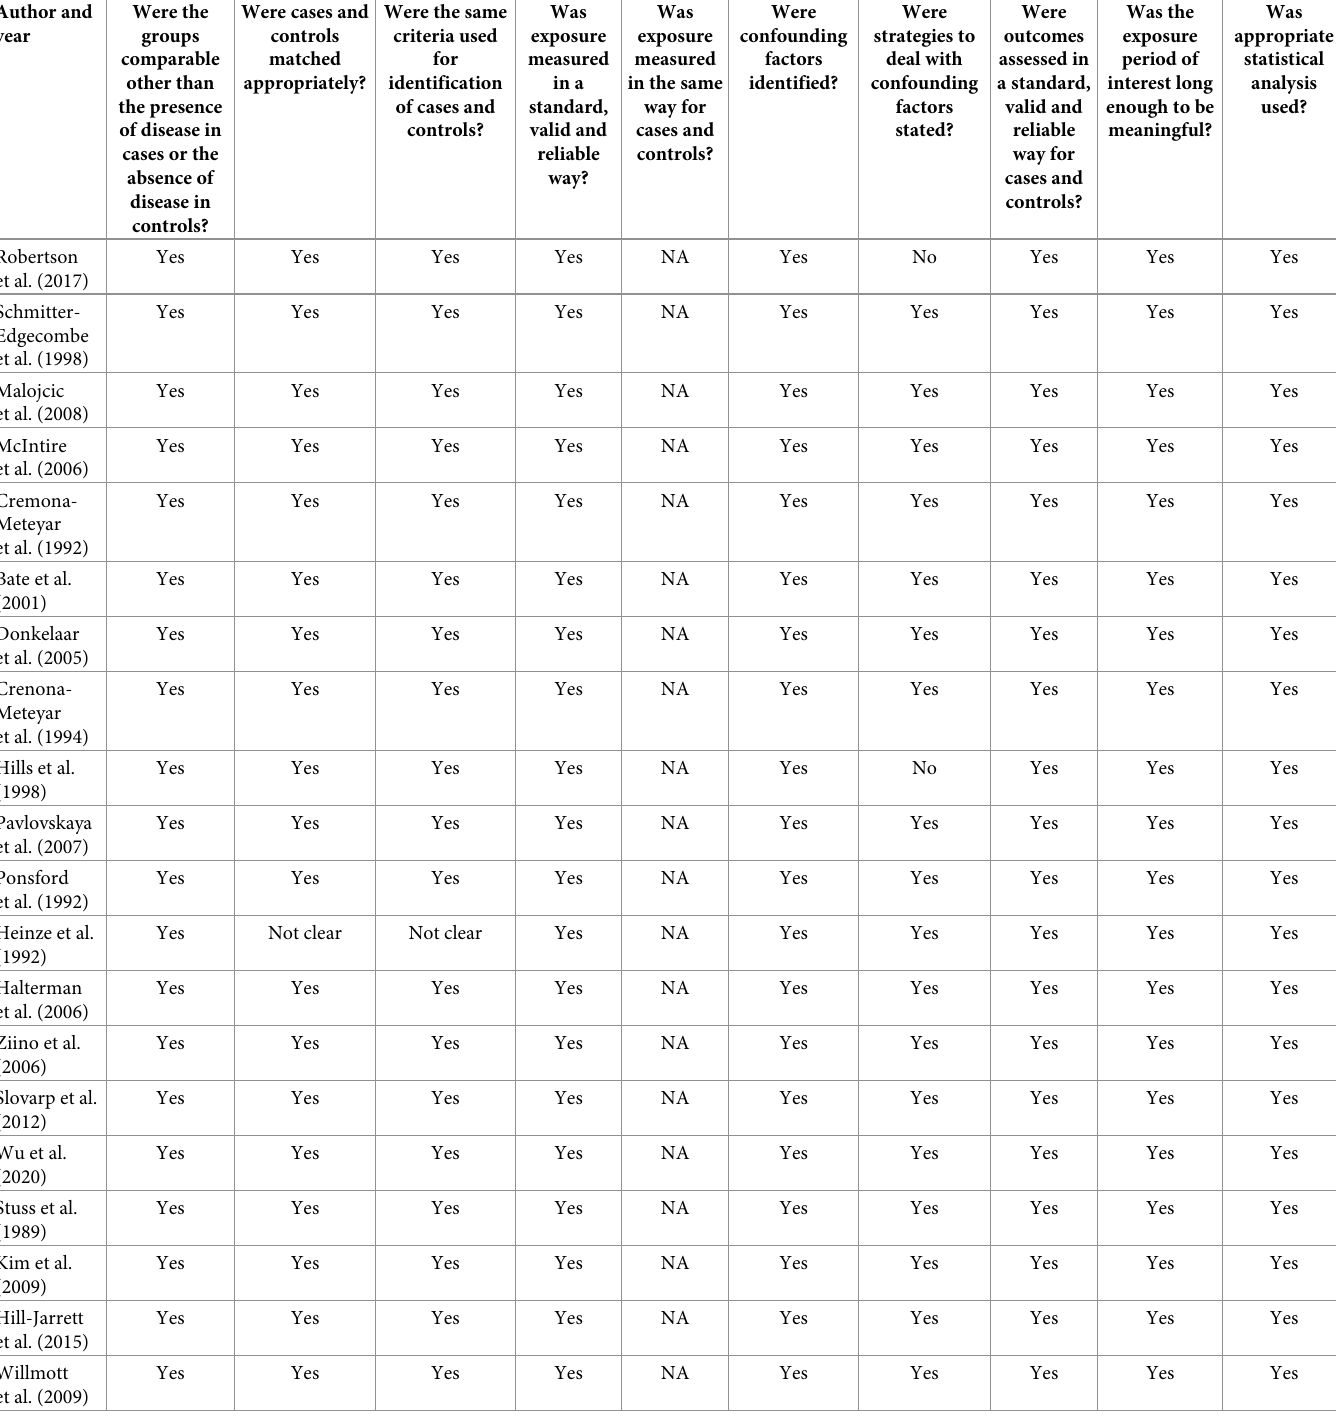
Table 2. The outcomes of an assessment of risk of bias of published studies included in the qualitative and quantitative analyses of the present